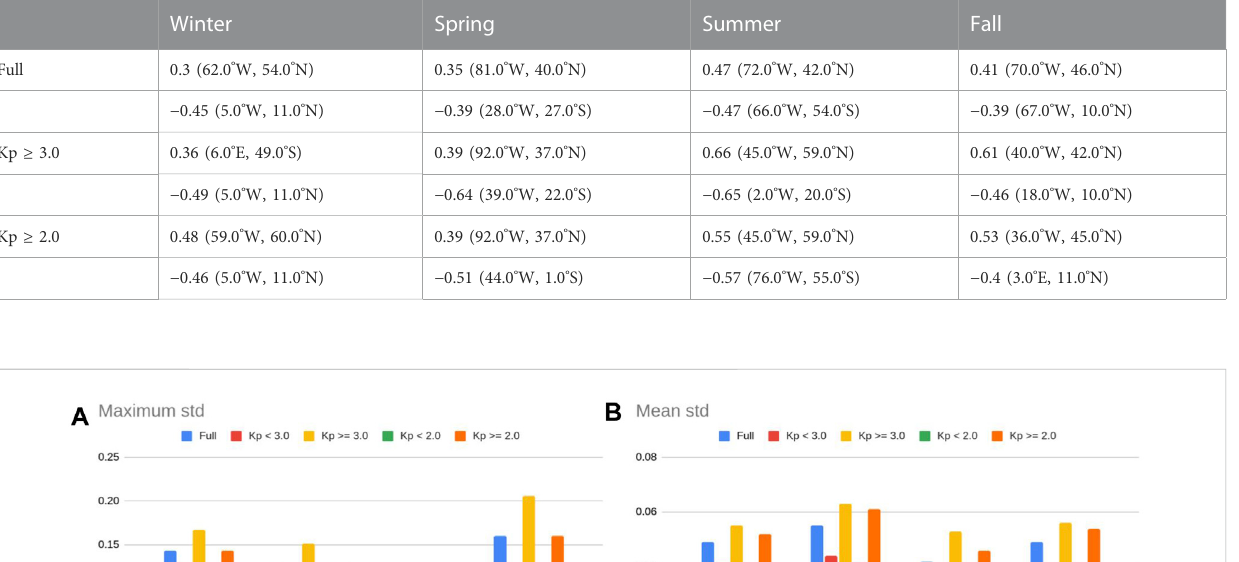
TABLE1Themaximumcorrelationandlargestanti-correlationforeachseasonandactivityclasswhichincludesactivetimedata.Thepositionofeachcorrelationis given in parentheses.